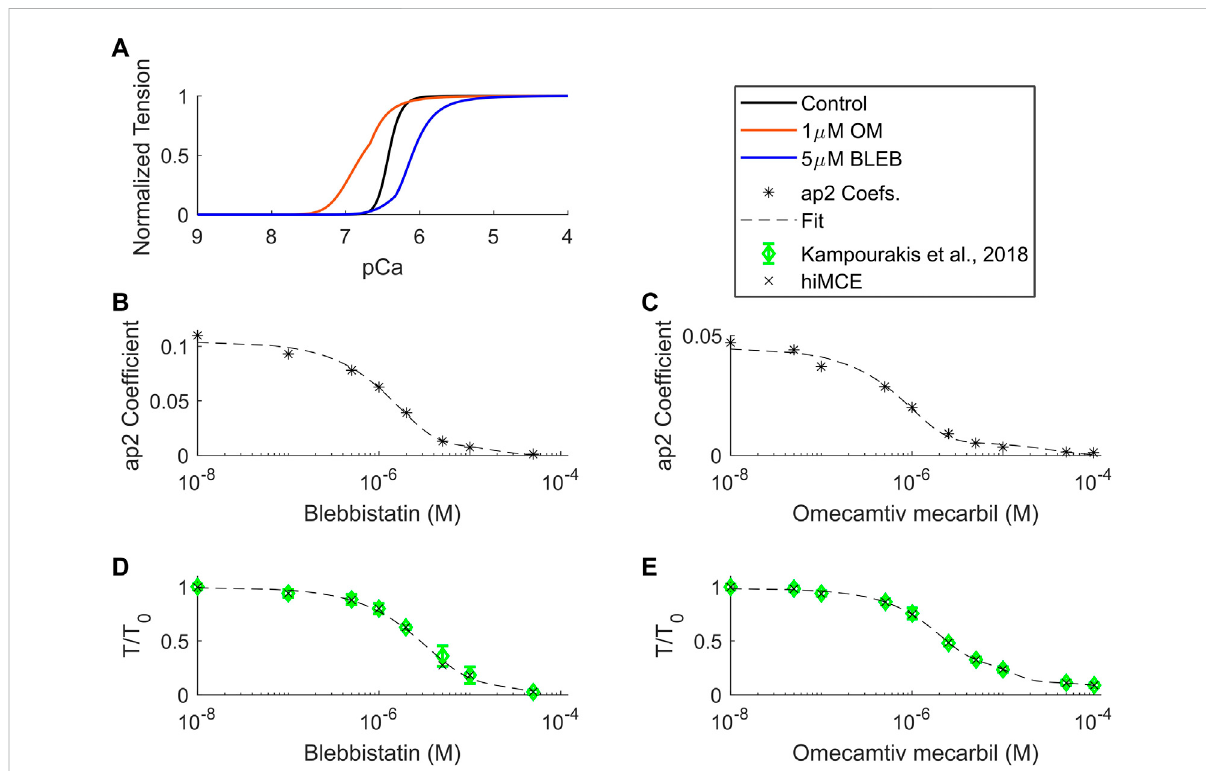
FIGURE 4 Calcium-tensionrelationships incontrol anddrug-induced modes inisometric condition (A) ,ap2 coef fi cients found for differentBLEBand OM concentrations (B,C) , and dose-dependent tension-Ca 2+ relationships of BLEB (D) and OM (E) in isometric conditions. OM: Omecamtive mecarbil. BLEB: Blebbistatin. Experimental data from (Kampourakis et al., 2018). T 0 : isometric force in the absence of